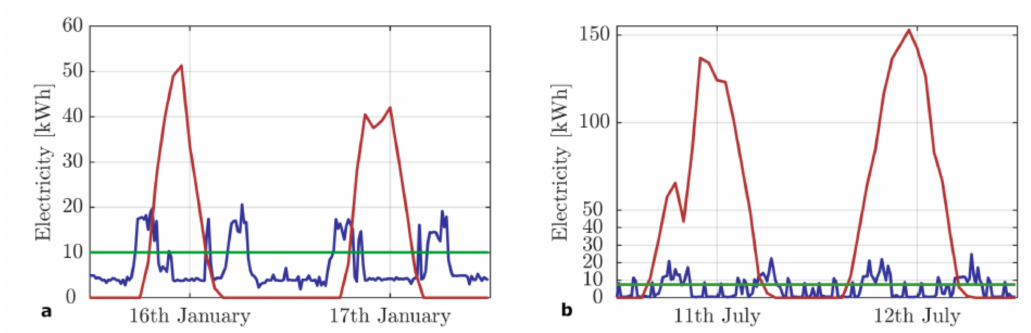
Figure 8. Farm’s power demand (blue) compared to the potential solar roof electricity generation (red) and electrical yield of a manure-based CHP plant (green) for two selected days. ( a ) depicts the situation in mid-January, and ( b ) shows the situation in